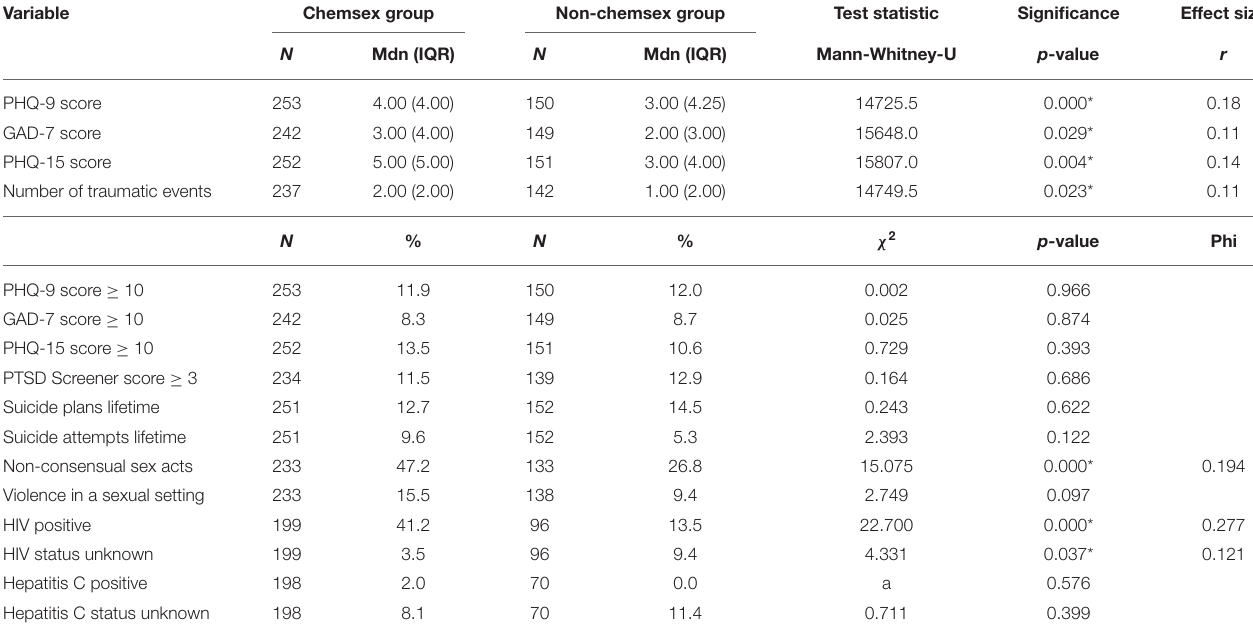
TABLE 2 | Group comparisons between chemsex group and non-chemsex group, Mann-Whitney- U test for metric variable, Chi-square test for categorical